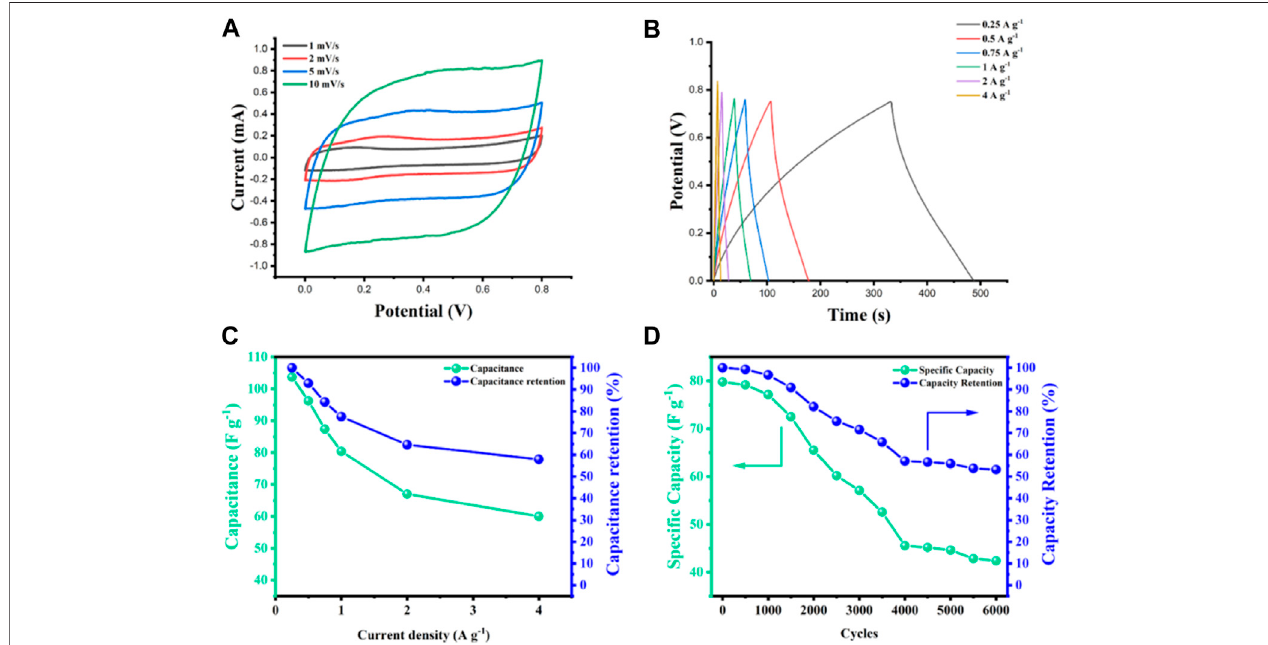
FIGURE 4 | Electrochemical performance of the ES fi bres carbonized at 1000 ° C after plasma treatment: (A) CV curves at different scan rates (B) Galvanostatic charge discharge (GCD) of at different current rates (C) Speci fi c capacitance at different current densities, (D) Cycling performance using 1.0 A g − 1 gravimetric current